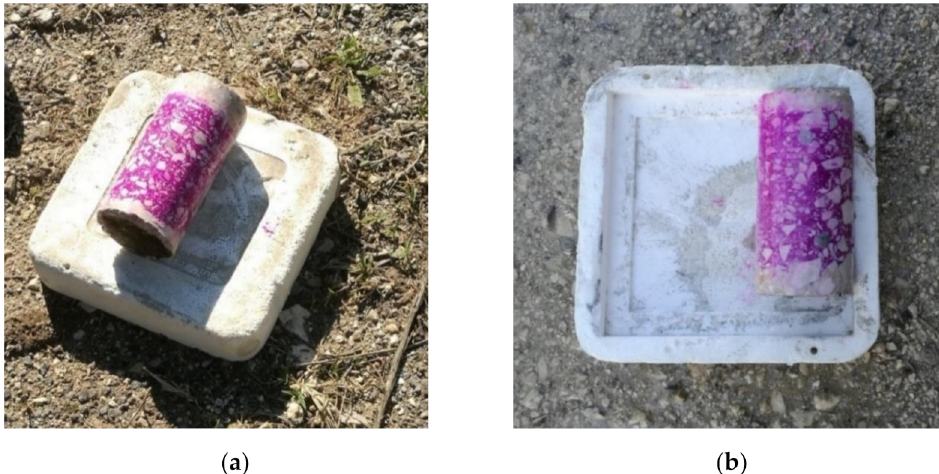
Figure 7. Samples B1_1 ( a ) and B1_2 ( b ) after phenolphthalein